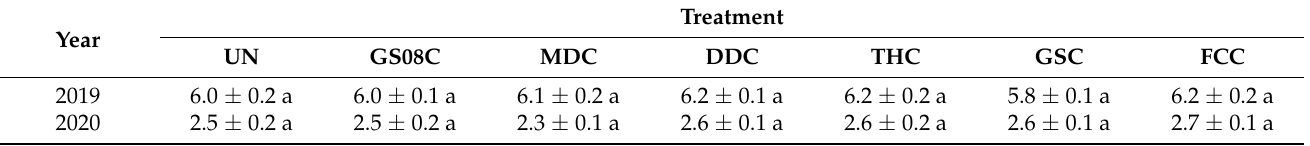
Table 5. Mean ( ± SE) grain yield (t ha − 1 ) of broad bean treated with insecticide at various times to control Sitona lineatus in Lithuania in 2019 and